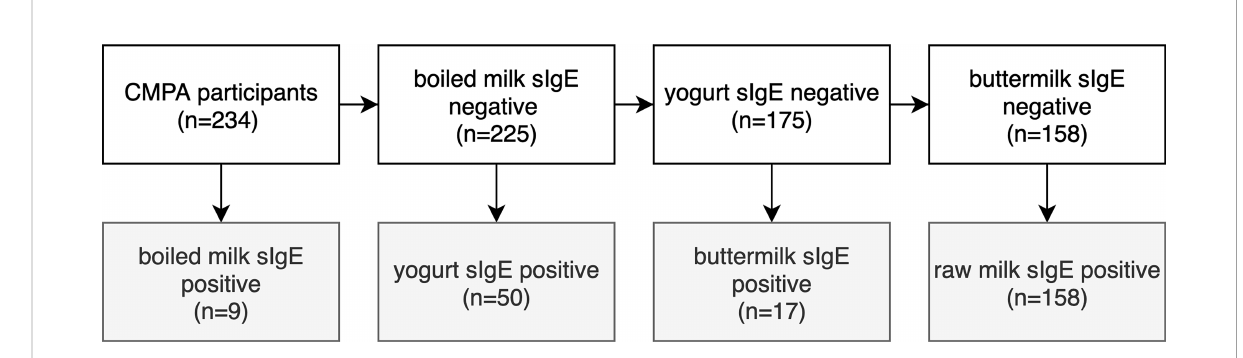
FIGURE 3 Flow diagram showing the distributions of participants according to the boiled milk, yogurt, butter milk and raw milk sIgE